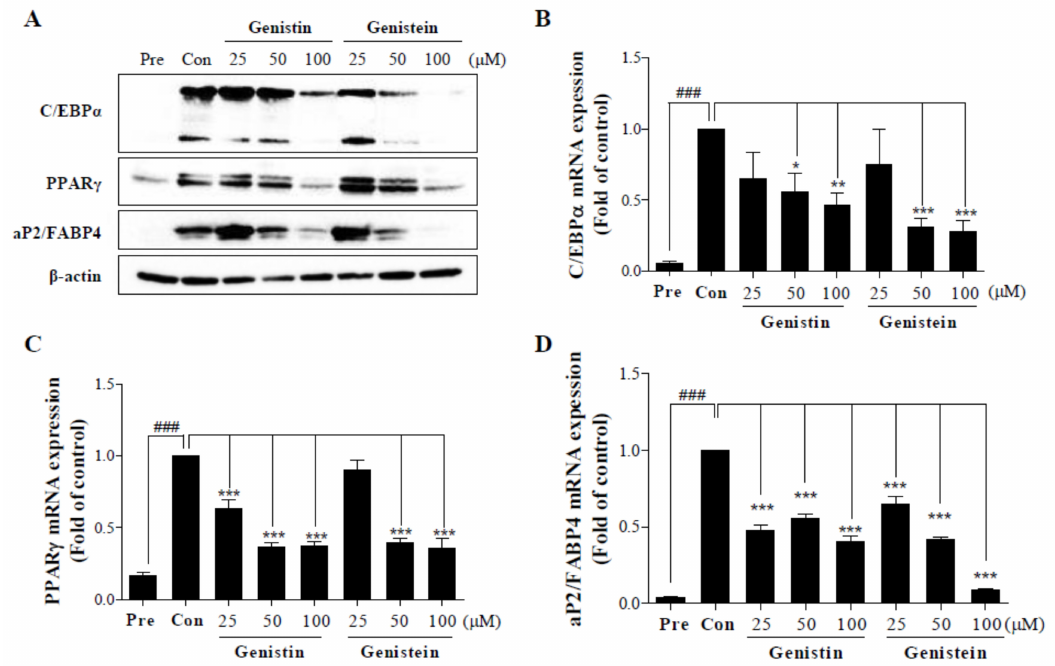
Figure 3. E ff ect of genistin and genistein on the protein expression and messenger RNA (mRNA) levels of adipogenic-specific factors in 3T3-L1 adipocytes. 3T3-L1 cells were completely di ff erentiated in the MDI media in the presence of 25, 50, or 100 µ M genistin or genistein during the di ff erentiation process. ( A ) Protein expression changes of C / EBP α , PPAR γ , and FABP4 in 3T3-L1 cells was monitored using Western blotting. ( B–D ) The mRNA expression of adipogenic factors, including ( B ) C / EBP α , ( C ) PPAR γ , and ( D ) aP2, was calculated. All data were expressed as fold changes in expression relative to that in the control, untreated adipocytes ( n ≥ 3, ### p < 0.001 vs. Pre (preadipocyte) group; * p < 0.05, ** p < 0.005, *** p < 0.001 vs. Con (control, adipocyte) group; one-way ANOVA with the